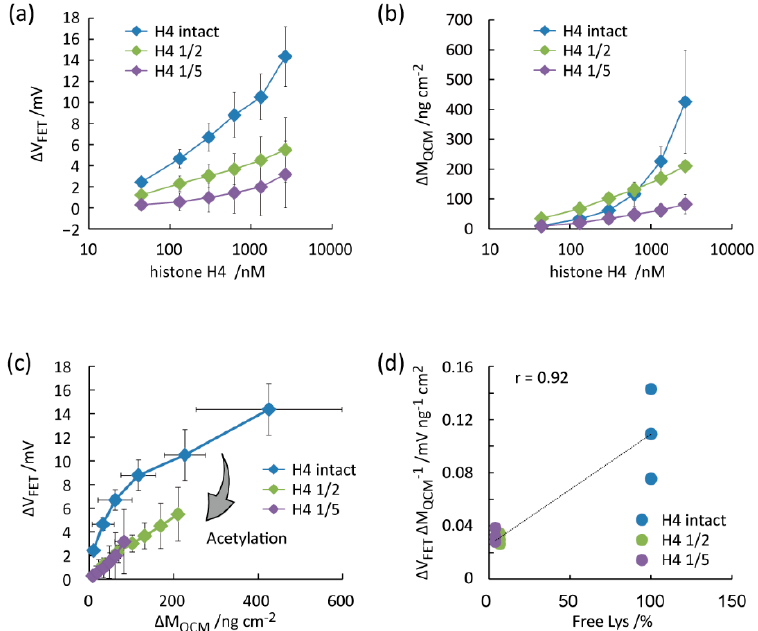
Figure 5. Evaluation of the degree of Lys acetylation in histone H4 treated with sulfo-NHS-acetate through parallel measurements of FET and QCM using the gold electrode functionalized by the anti-histone H4 aptamer and SB SAM. ( a ) ∆ V FET vs. histone H4 concentration. ( b ) ∆ M QCM vs. histone H4 concentration. ( c ) ∆ V FET vs. ∆ M QCM . ( d ) ∆ V FET / ∆ M QCM vs. free Lys contents in histone H4.